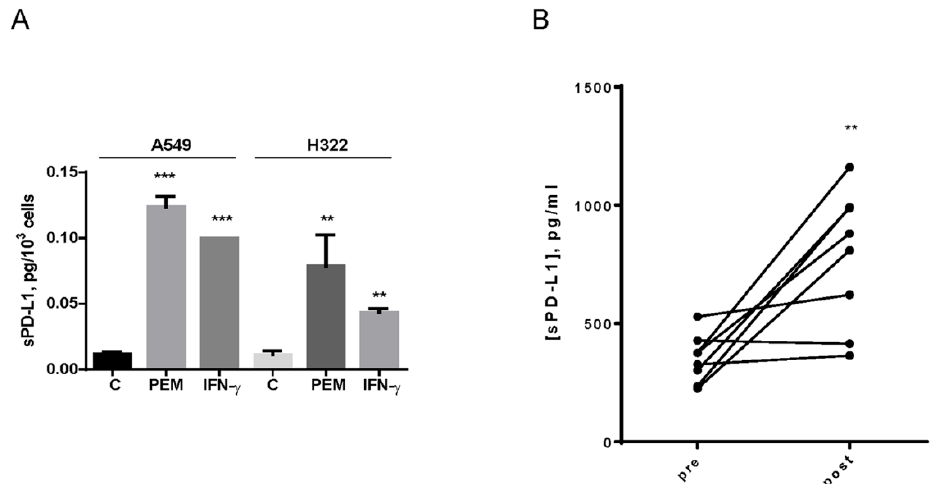
Figure 6. sPD-L1 levels in cell culture medium and in plasma from NSCLC patients treated with pemetrexed. ( A ) A549 and H322 cells were treated with 100 nM pemetrexed for 3 days; at the end, sPD-L1 was quantified by ELISA assay in the culture medium and data were normalized to cell number. IFN- γ at 10 ng/mL was used as an internal control. Data are representative of three independent experiments. ( B ) sPD-L1 detected in plasma from 8 NSCLC patients by ELISA assay before and after 4 days of pemetrexed treatment. ** p < 0.01; *** p < 0.001.